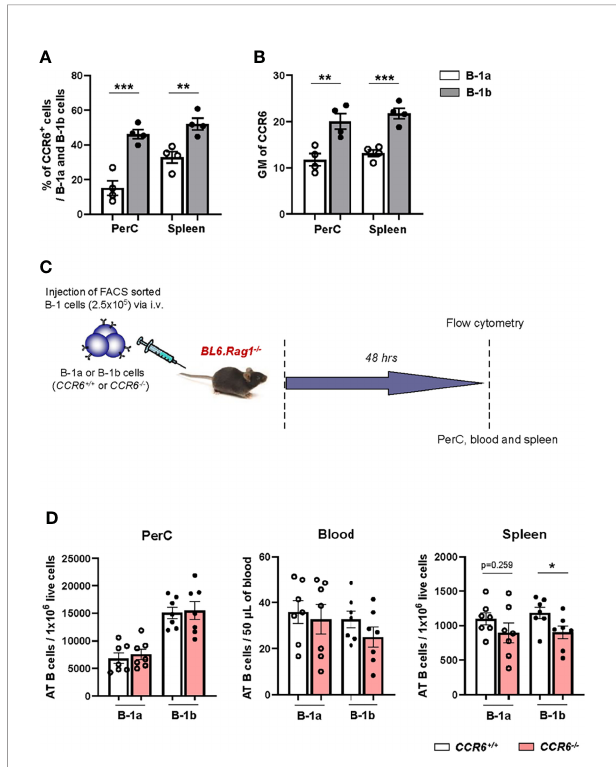
DC FIGURE 3 | B-1b cells express high amounts of surface expression of CCR6 and this CCR6 is important for B-1b cell migration to spleen. (A) Frequency of CCR6 + B-1a and B-1b cells in PerC and spleen (n=4 mice). (B) quanti fi cation of geometric mean (GM) of CCR6 expression on B-1a and B-1b cells in PerC and spleen (n=4 mice). Data is from single experiment. (C) Schematic representation of the experiment. FACS sorted B-1a or B-1b cells from CCR6 +/+ and CCR6 -/- mice were adoptively transferred (250,000 cells/mouse) into Rag1 -/- mice via tail vain injection. (D) Adoptively transferred (AT) B cells from live single cells were quanti fi ed in peritoneal cavity (PerC), blood and spleen by fl ow cytometry. Data is from two independent experiments (n=7 mice/group). Results are represented in mean + SEM, unpaired Mann-Whitney test was performed. *p < 0.05, **p < 0.01, ***p <